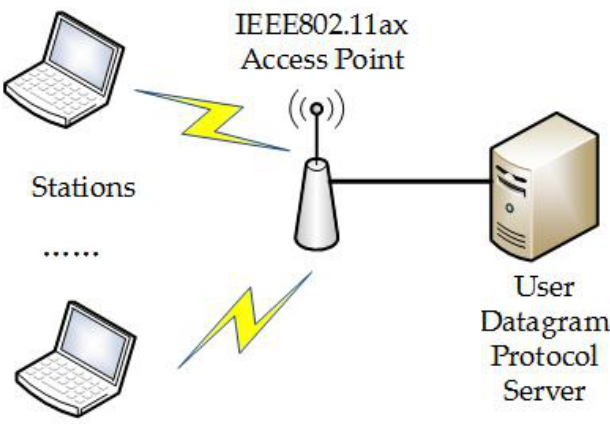
Figure 11. The topology of the experimental network. Table 1. Parameters for the WLAN